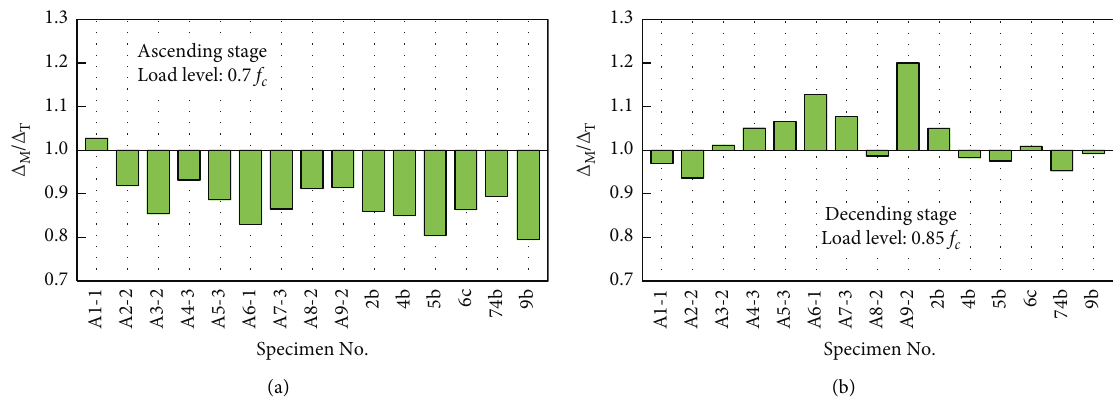
Figure 25: Further verification of the proposed model.